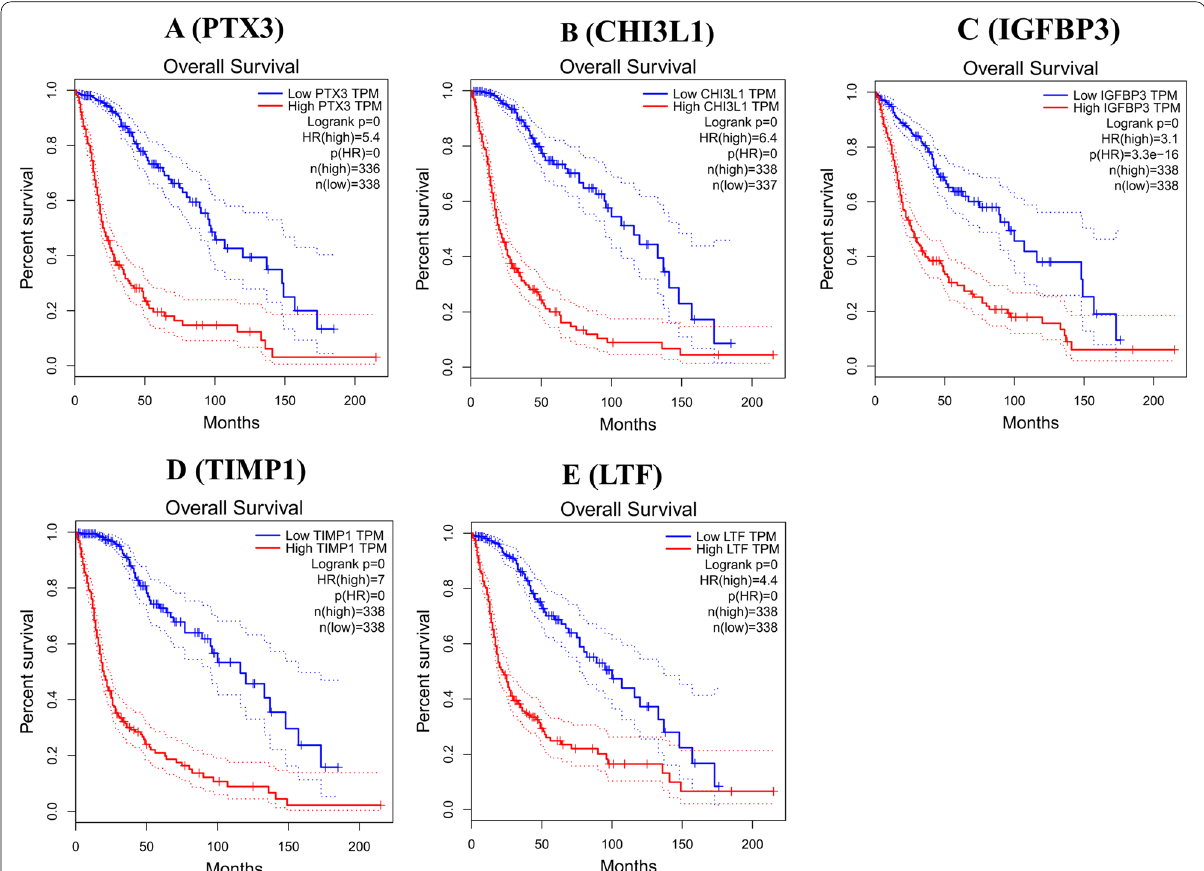
Fig. 5 Kaplan–Meier survival curves using The Cancer Genome Atlas database validate the prognostic value of genes expressed in gliomas (blue— low risk; red—high